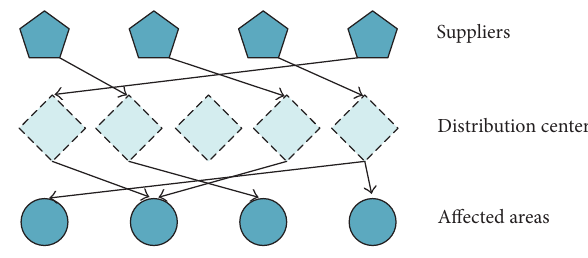
Figure 1: An example for emergency network